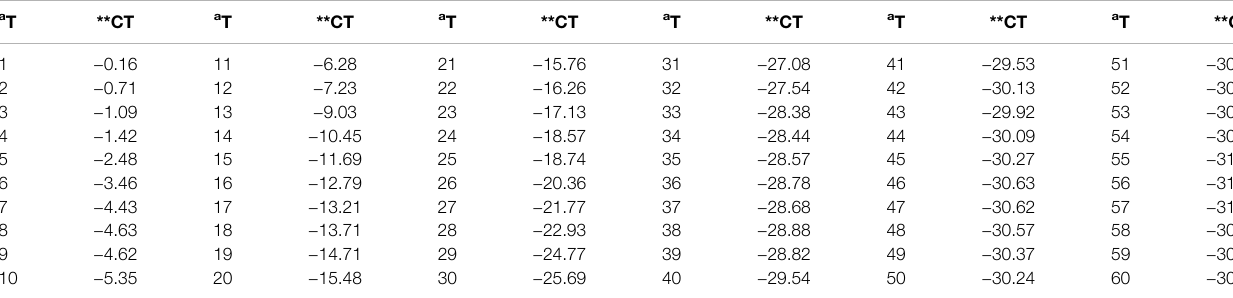
TABLE 5 | The fi rst stage monitoring values of a measuring point in Zhanshan Station.